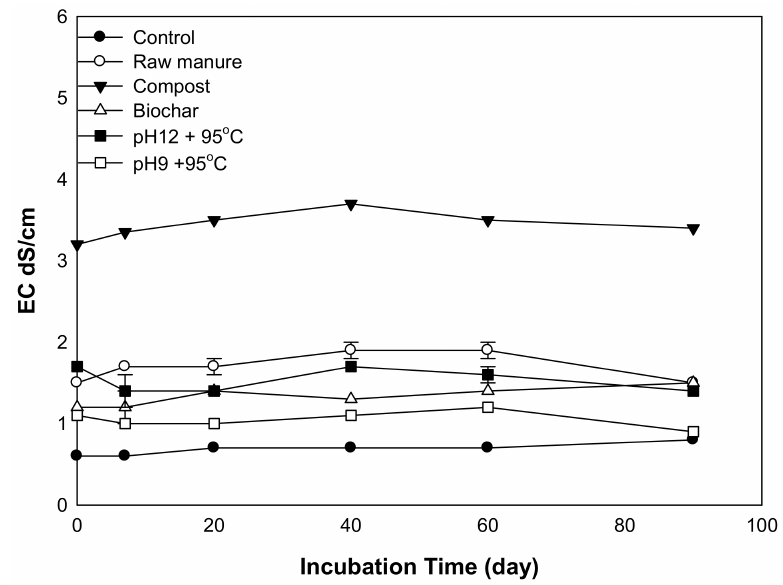
Figure 2. Variation in soil EC affected by different organic amendments derived from cow manure at different incubation times.